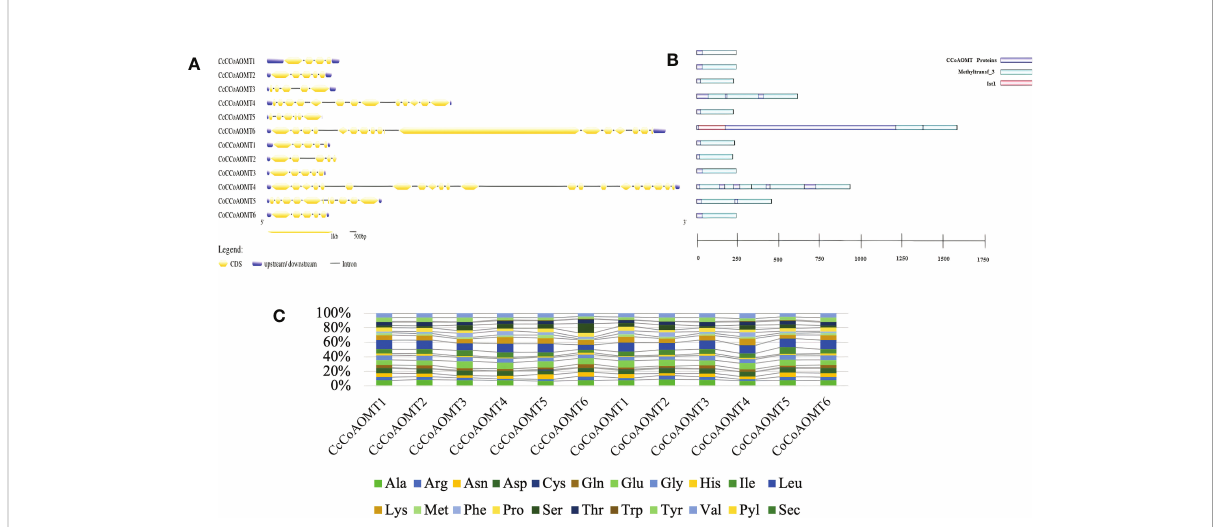
FIGURE 4 Overview of gene structure, domain architecture and amino acid composition of CCoAOMT members in jute. (A) Exon-intron distribution of all CCoAOMT genes discovered in C capsularis and C olitorius . Exon and UTR regions are represented by yellow and green boxes, respectively, while introns are represented by black lines. (B) Domain analysis of CCoAOMT proteins from the two species. Green boxes represent the identifying domain Methyltransf_3 and pink box Ist1 domain. (C) A stacked bar plot depicting the amino acid (aa) composition of CCoAOMT proteins in both species. Each amino acid ’ s percentage content is displayed in a different